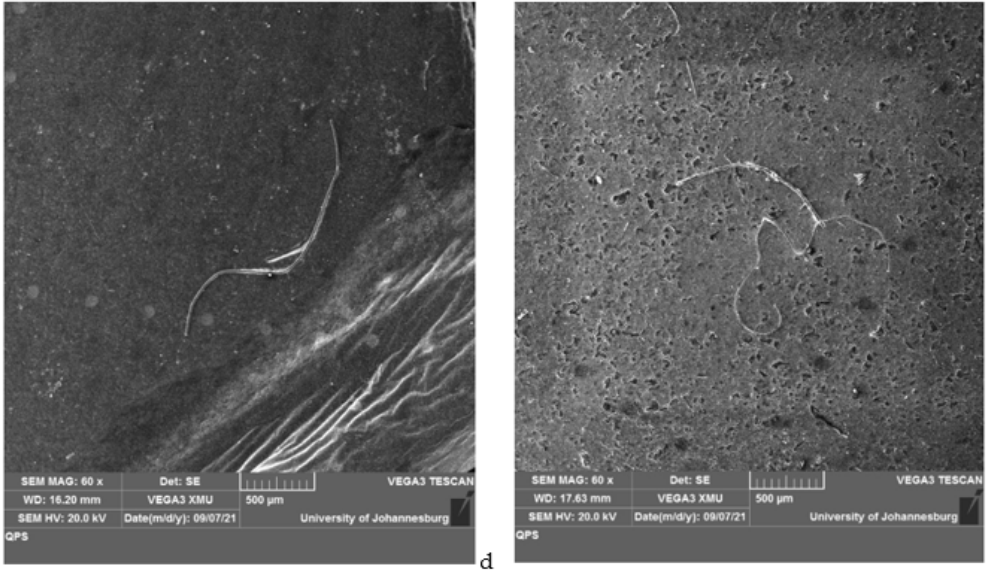
Figure 4. SEM images of microplastics filtered through PVDF membranes from ( a ) tap water, ( b ) lake water, ( c ) influent, and ( d ) effluent.